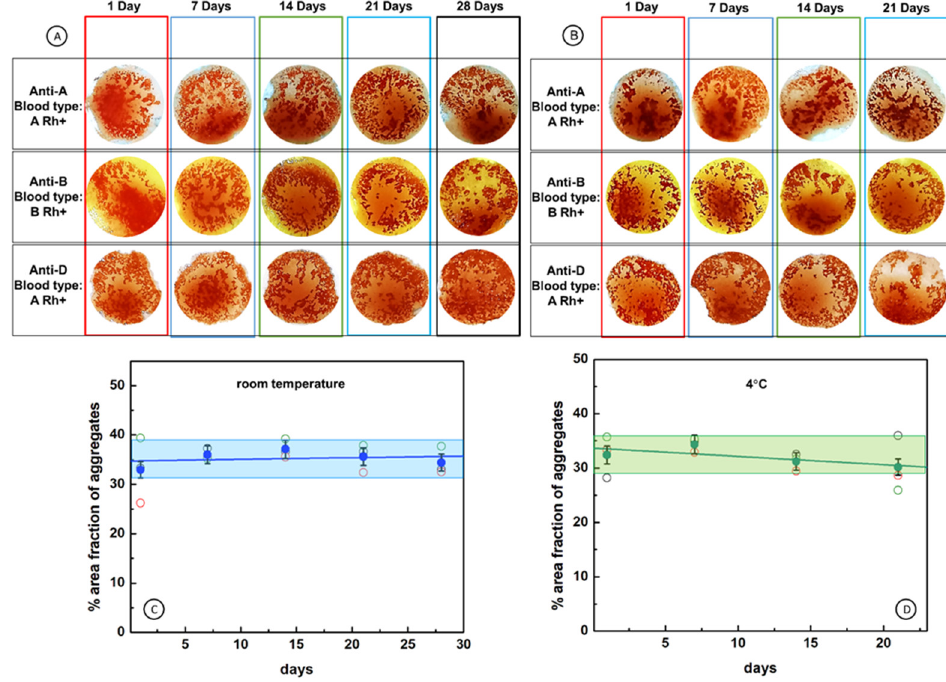
Figure 7. Stability of antibodies immobilized on immunostrips IMS-50 by supramolecular interactions and durability of immunostrips. ( A , B ) Images showing positive response of immunostrips stored at: ( A ) room temperature and (B) 4 °C; ( C , D ) durability of immunostrips stored at different temperatures: ( C ) room and ( D ) 4 °C, for different kinds of antibodies: anti-A (black open circle), anti-B (red open circle), anti-D (green open circle), mean—blue filled circle for room temperature and green filled circle for 4 °C. All experiments were performed on immunostrips and reagents warmed to room temperature.